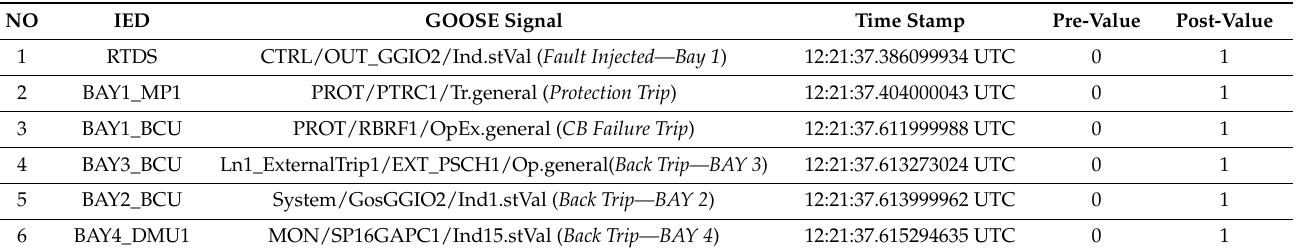
Table 4. Exchanged GOOSE data during a CB failure event in Bay